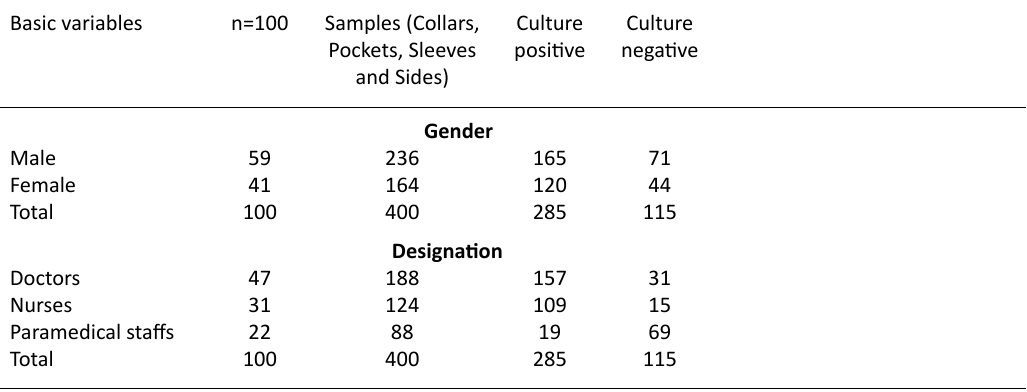
table 1. Basic variables Basic